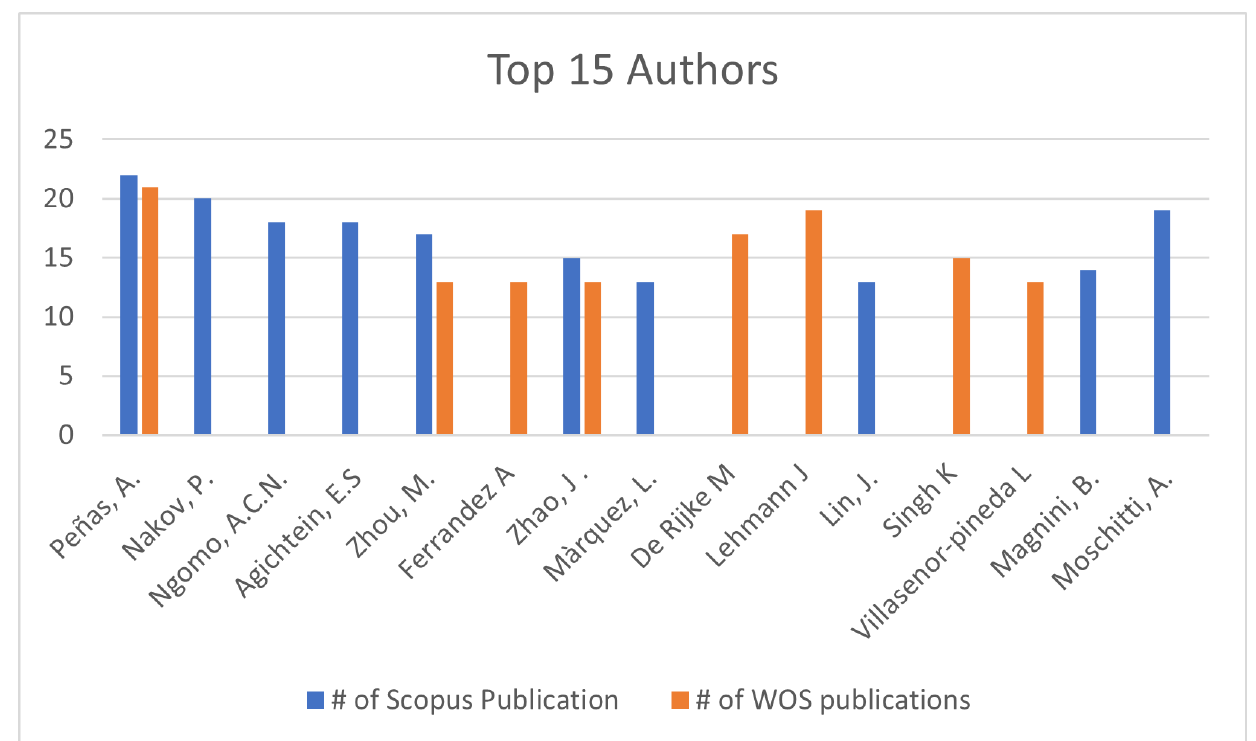
Figure 7. Top 15